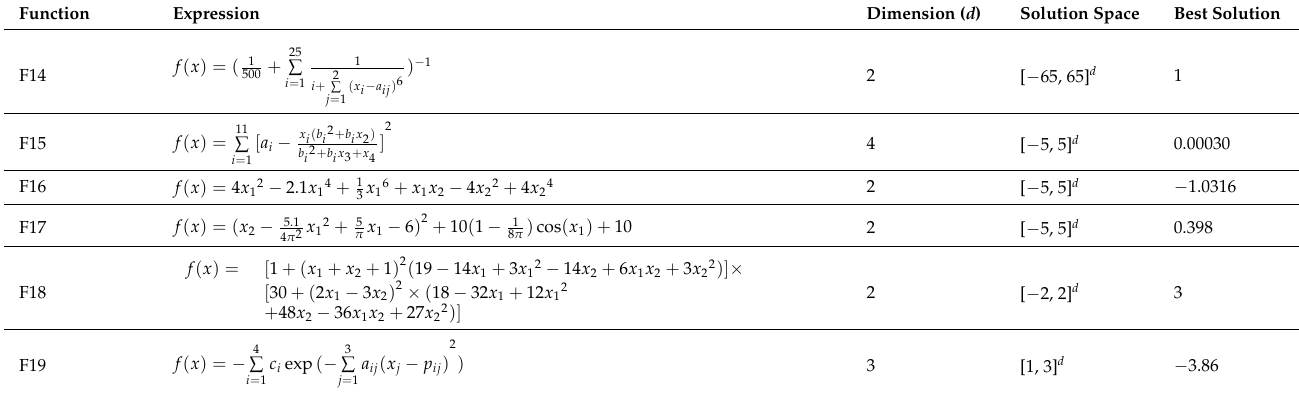
Table 4. Fixed-dimension multimodal standard famous